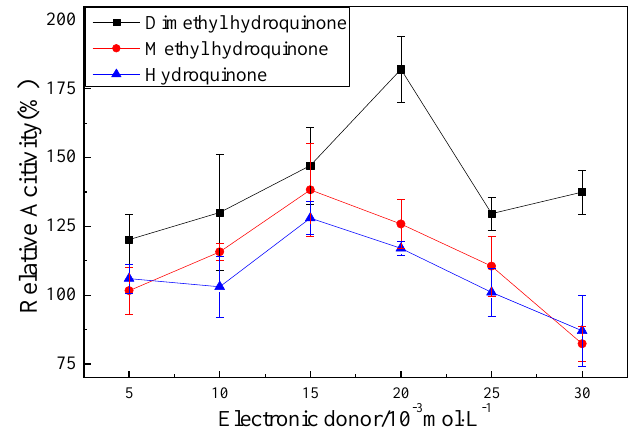
Figure 9. The effect of three kinds of hydroquinone on the MMO activity of membrane fractions (100% epoxidation activity = 2.68, 2.71, and 3.12 nmol∙min −1 ∙mg −1 ).